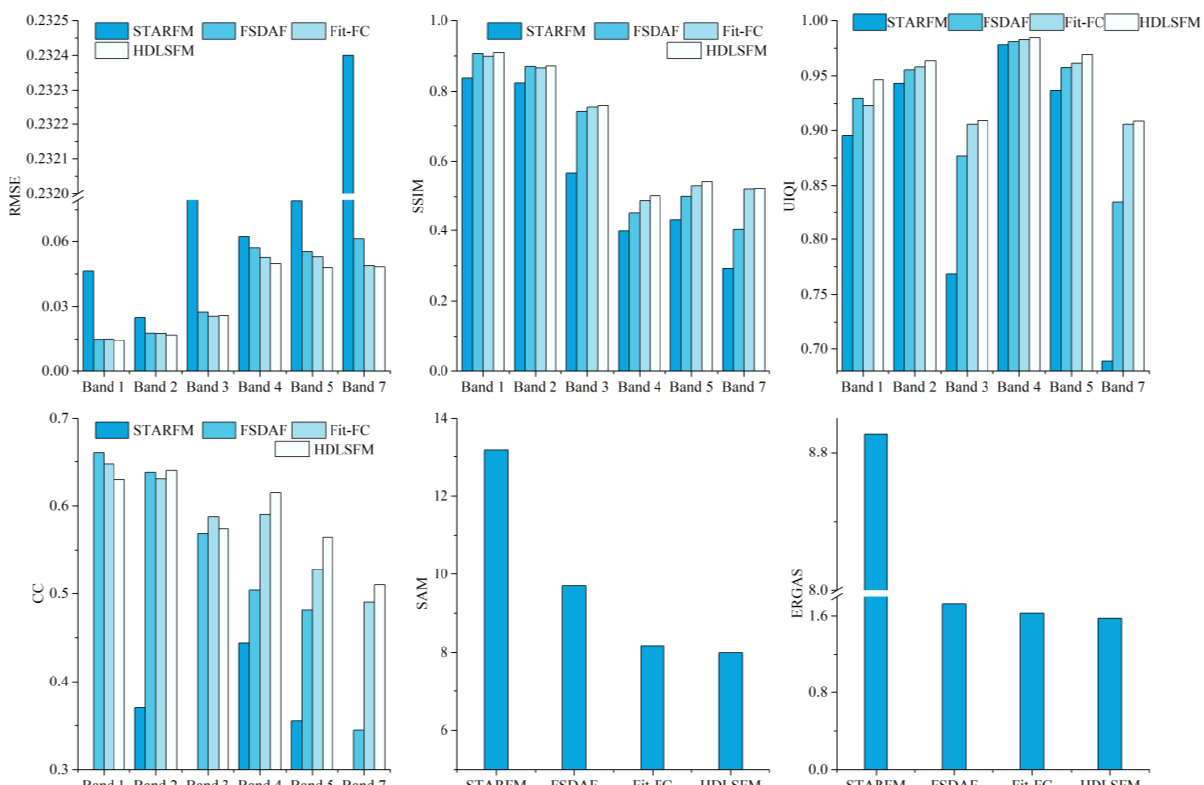
Figure 8. Quantitative assessment of the prediction results of different STF methods for the CI site.